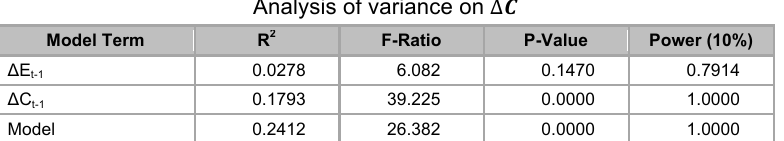
Analysis of variance on ∆